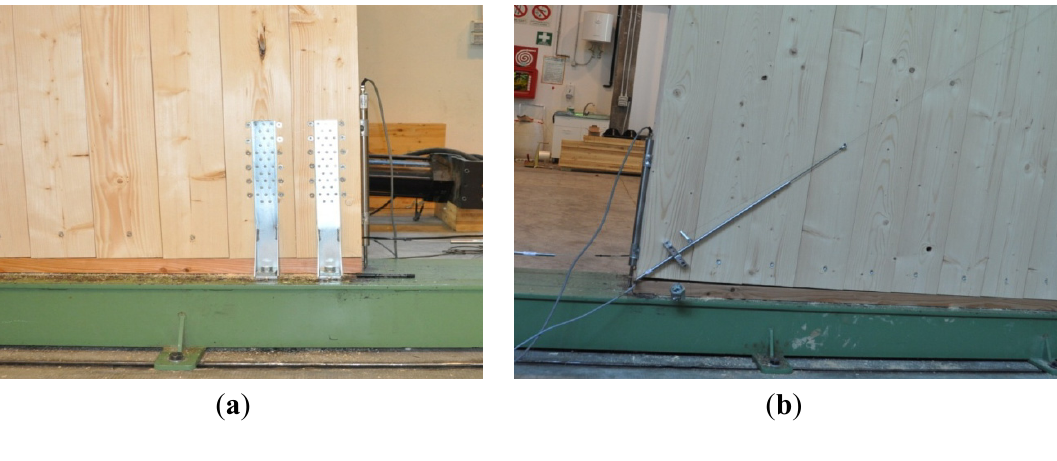
Figure 14. Wall C: Details of connection system at end of testing: ( a ) uplift of hold-downs; ( b ) deformation on rear face.